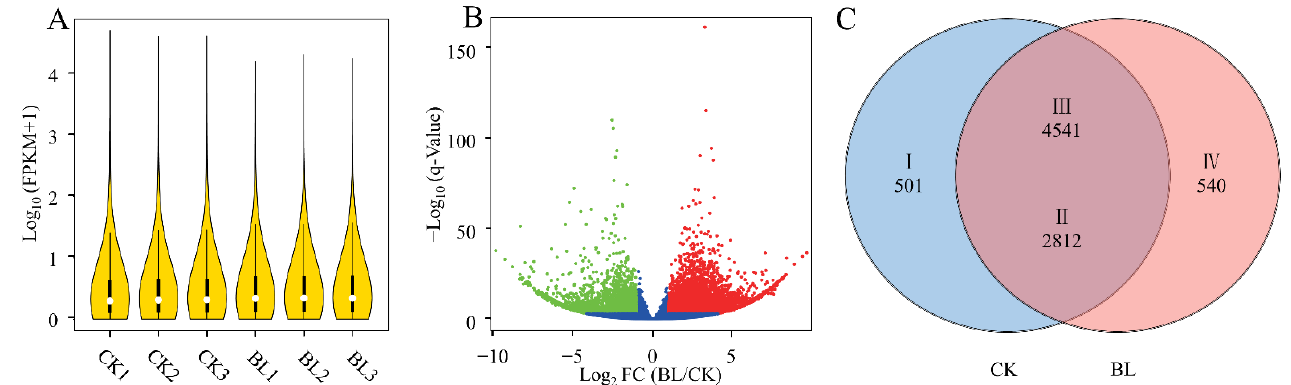
Figure 2. Screening of differentially expressed genes. ( A ) Distributions of gene expressions for the six samples. ( B ) DEGs were screened under the conditions of |log 2 FoldChange| ≥ 1 and Q -Values < 0.001 (the red dots and the green dots indicate DEGs upregulated and downregulated in the BL treatment, respectively). ( C ) Venn diagram of the DEGs distributing in CK and BL treatments (I and II show the DEGs downregulated in the BL treatment; III and IV show the DEGs upregulated in the BL treatment. The DEGs belonging to I and IV were only expressed in CK and BL treatments, respectively; the same below).